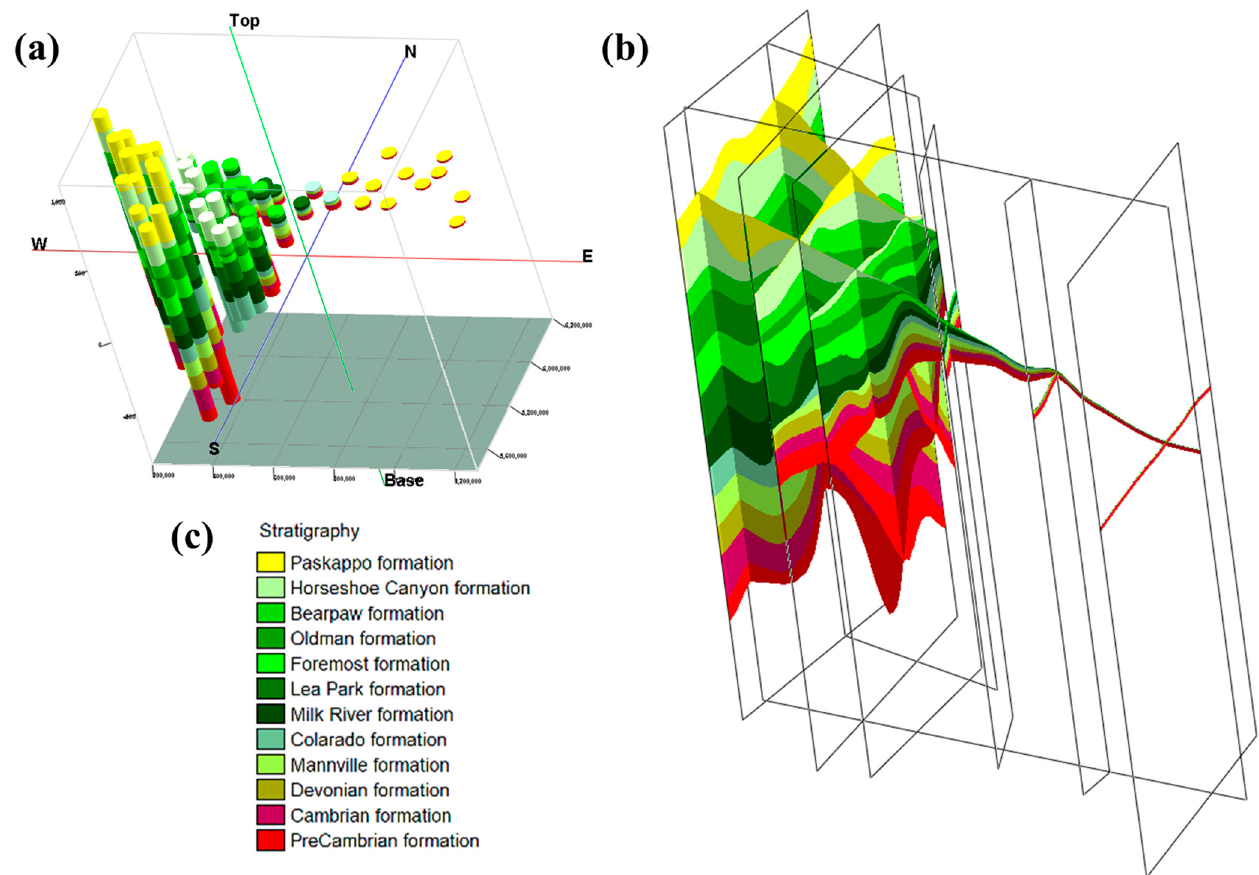
Figure 4. ( a ) Stratigraphic log of the boreholes used in 3D geological modeling. ( b ) Fence diagram of the geological model. ( c ) Legend of the modeled geological formations.